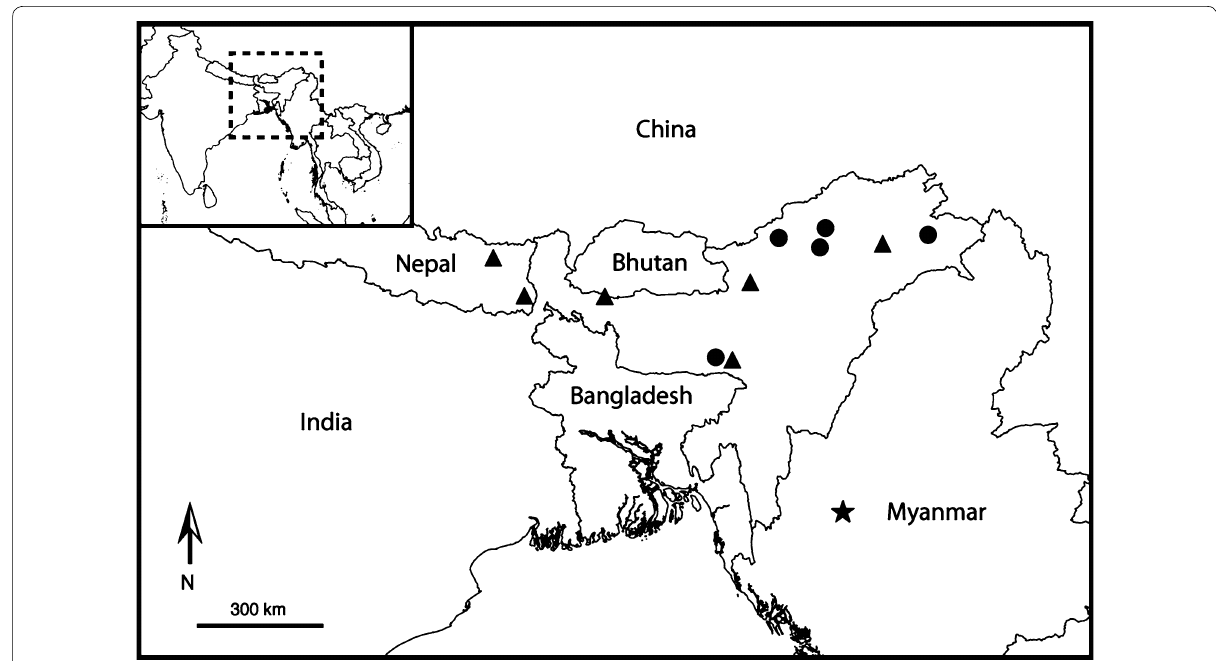
Fig. 5 Distribution map of Begonia griffithiana ( circle ), B. myanmarica ( star ), B. nepalensis ( trangle ). Distribution data of B. griffithiana and B. nepalensis is based on GPS data in the Begonia Resource Center (Hughes et al.